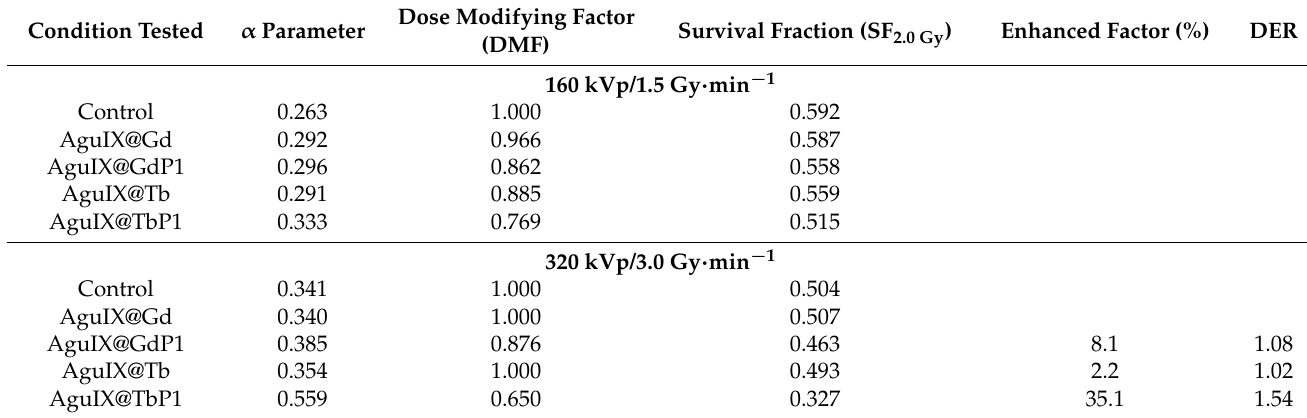
Table 1. LQ model parameters for the range of 0–5.0 Gy